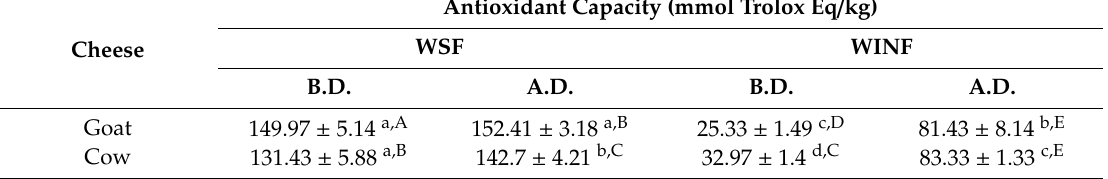
Table 3. Antioxidant capacity of protein fractions of experimental white-brined cheeses before and after in vitro digestion